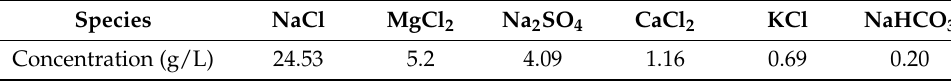
Table 2. Species composition of standard seawater